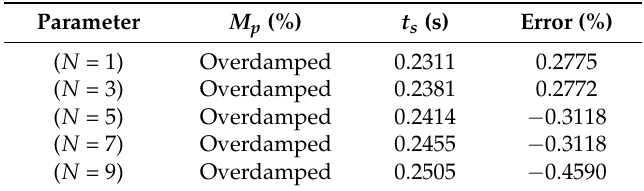
Transient results for the experimental test when the system works in closed loop with